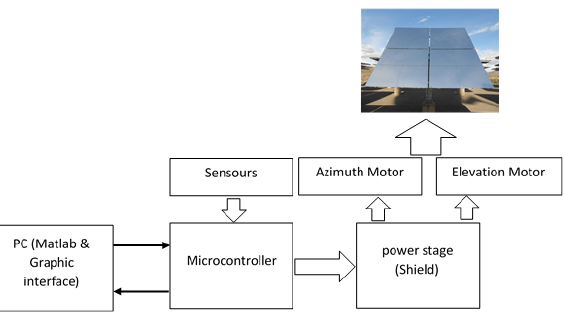
Fig. 2. Synoptic diagram of our